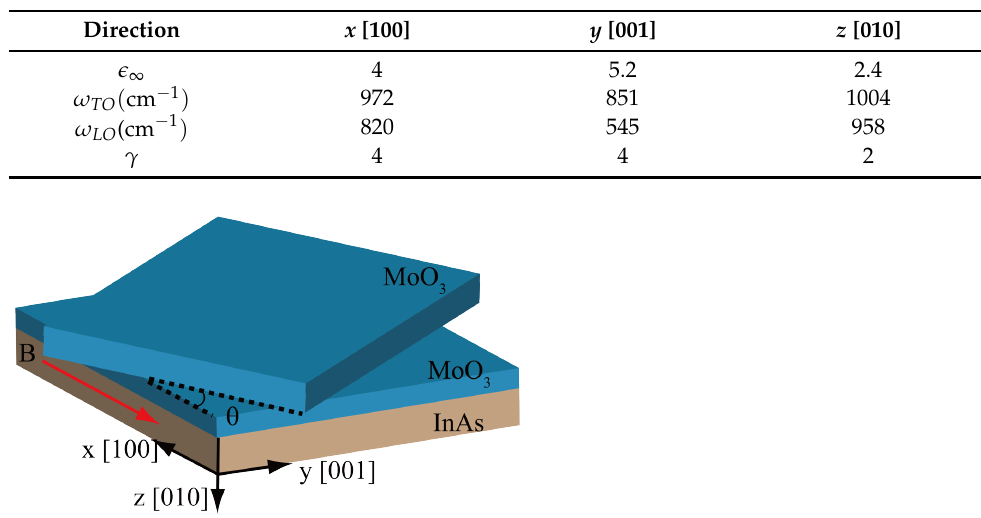
Table 1. Permittivity parameters for α - MoO 3 .